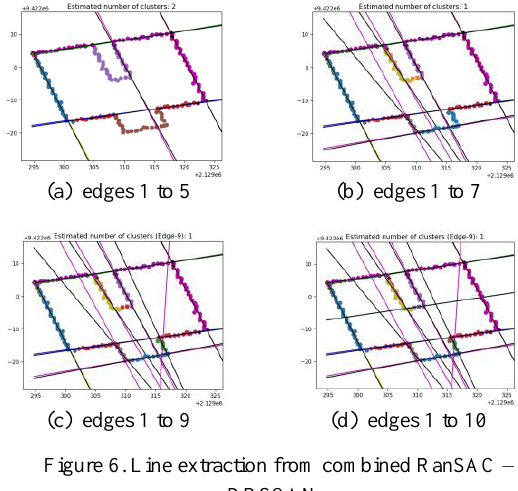
roof. Edge line extraction is initiated from the farthest corner point from the centroid in the longest edge (typically has most points).